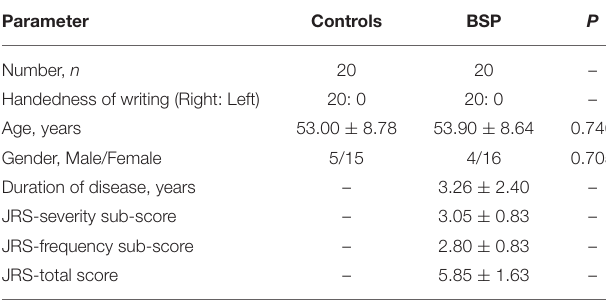
TABLE 1 | Demographic and clinical characteristics of the total